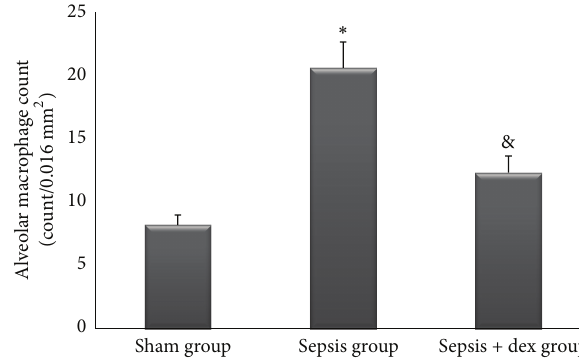
Figure 2: Plasma neutrophil gelatinase-associated lipocalin in experimental groups. ∗ 𝑃 < 0.05 compared with sham and sepsis + dex groups.